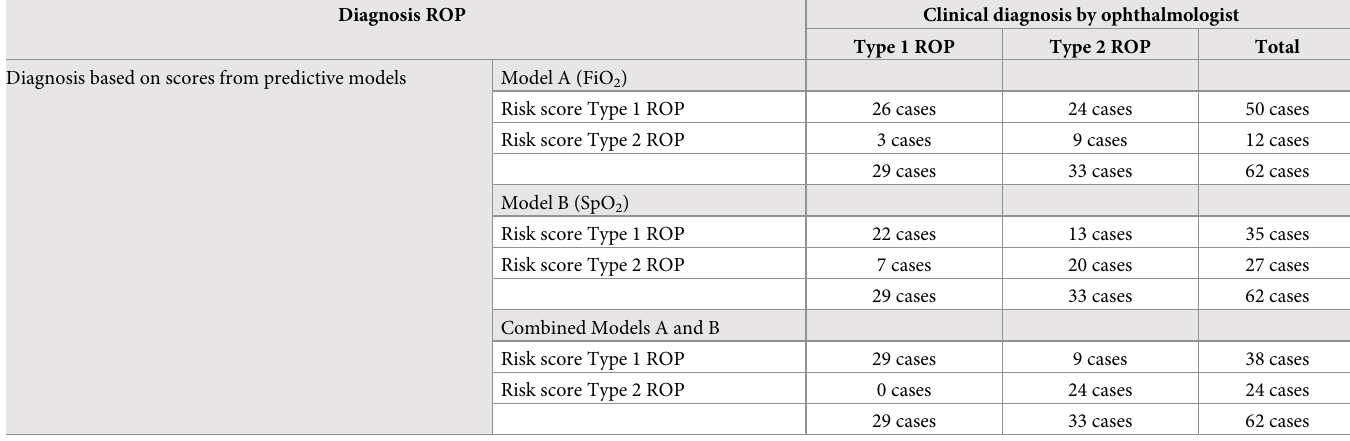
Table 5. The 2 x 2 table to calculate the diagnostic test of the scoring system against the gold standard clinical